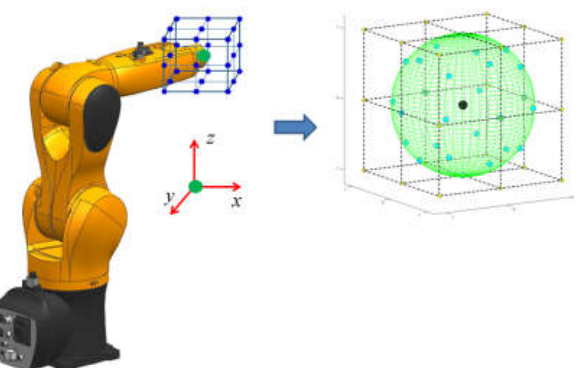
Figure 2. Schematic of a local search map within a sampling period in SbOSMS and our proposal. The set of all blue dots located on the surface of the green sphere in the right half of the diagram forms the search map for the SbOSMS method during a single sampling period. This paper attempts to extend the local search map within a single sampling period from these “special point sets” to the entire green sphere surface area.